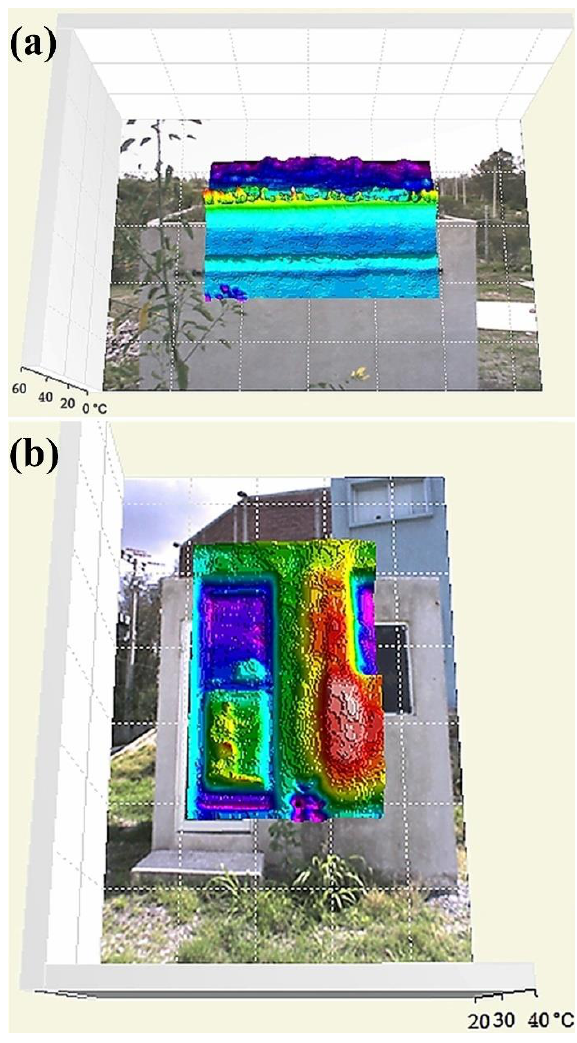
Figure 6. Thermograph image: ( a ) rear view and ( b ) façade view.